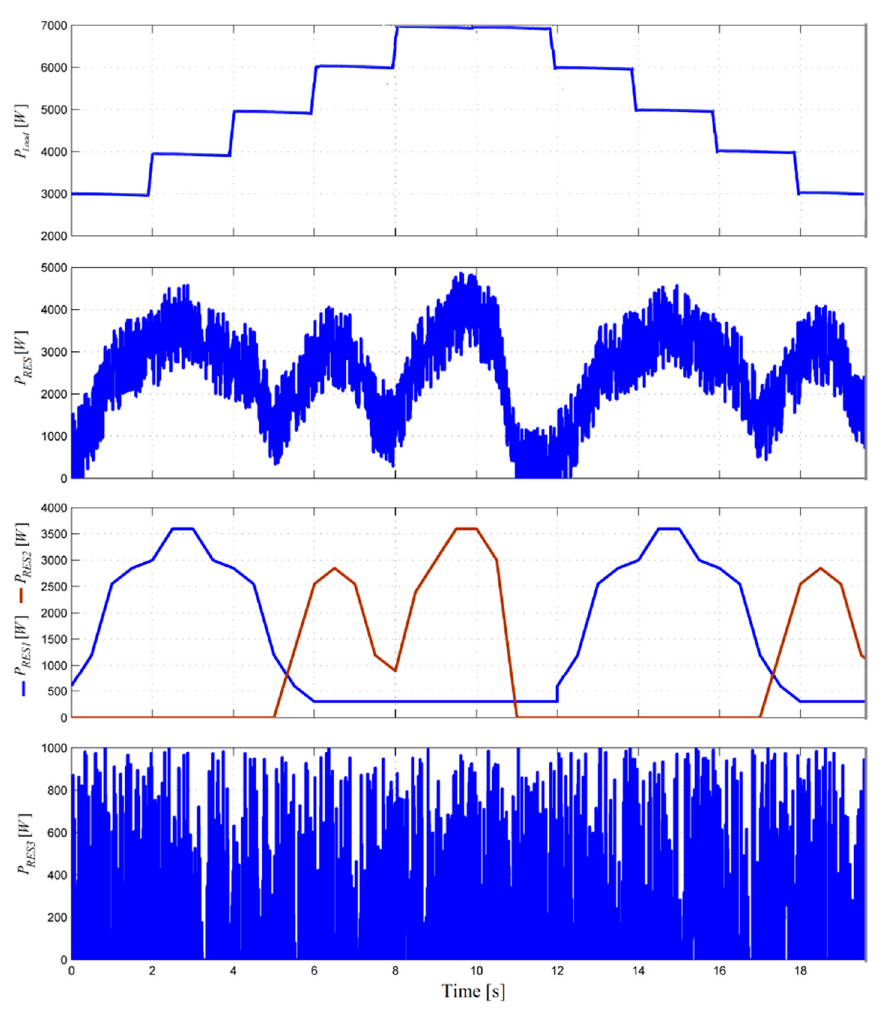
Figure 2. Profiles of the load demand and renewable energy.